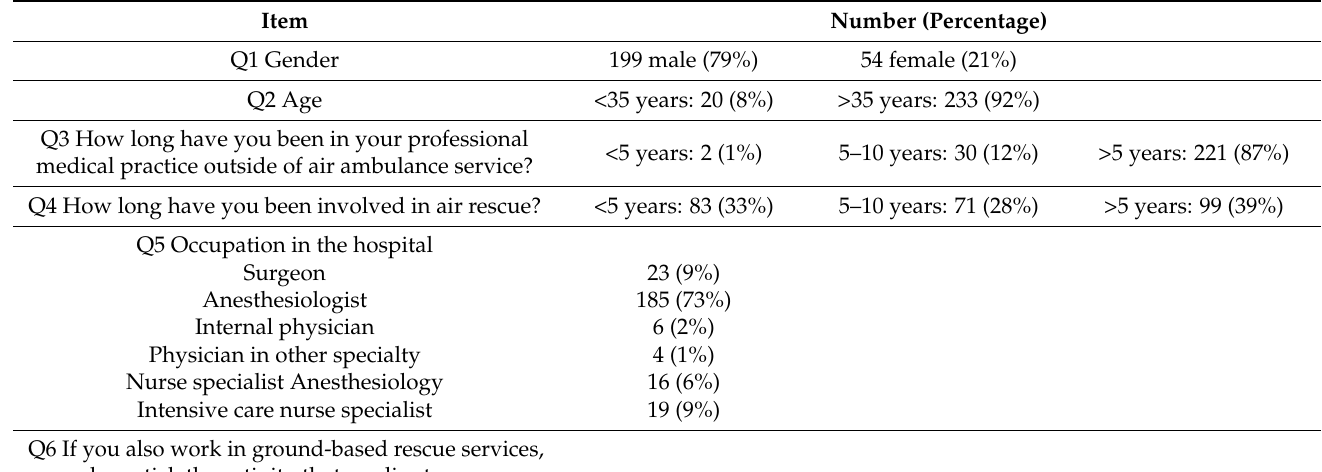
Table 3. Results of items Q1 to Q6 (respondents’ general data) with row percentage in brackets.